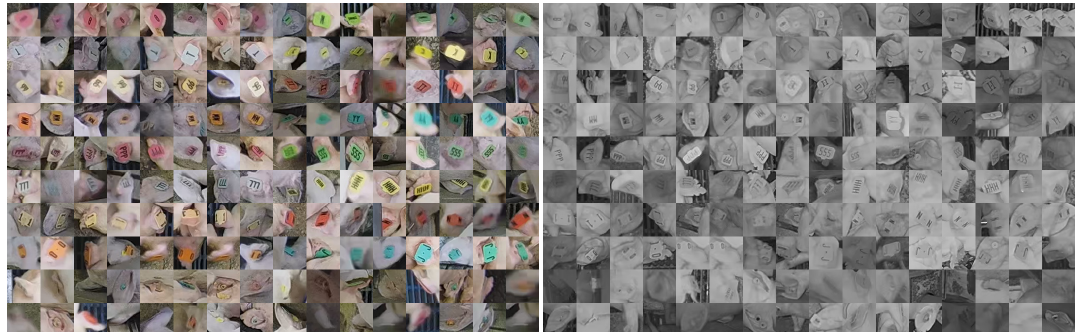
Figure 8. Samples of each tag crops used to train the deep classification network. The left image depicts crops taken from daytime color images and the right image depicts crops taken from nighttime infrared images. The first eight rows provide samples of each of the 16 tag types. The last two rows illustrate samples from the unknown tag ID